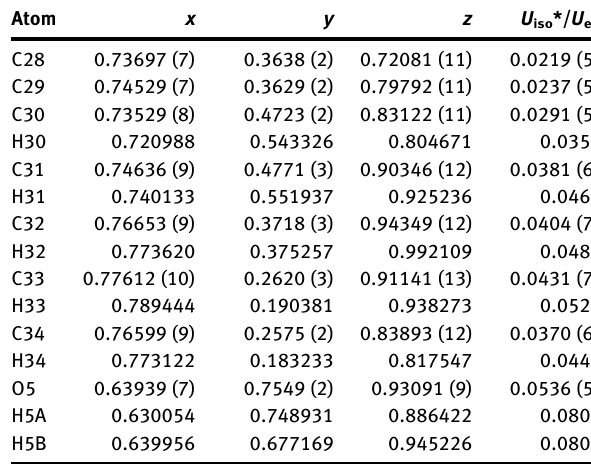
Table  : Fractional atomic coordinates and isotropic or equivalent isotropic displacement parameters (Å 